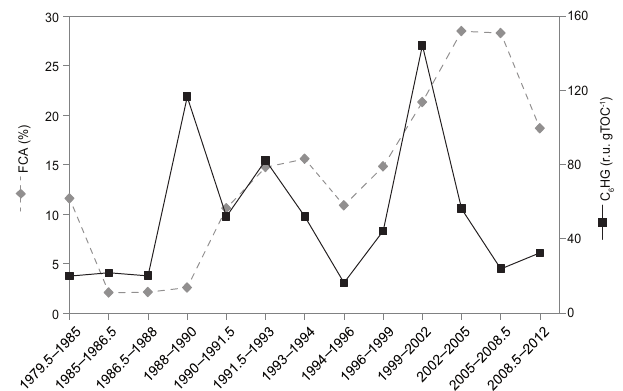
Figure 6. Abundance of heterocyst glycolipids (HGs) in the Baltic Sea over the period 1977–2012 (from MUC) compared with the fractional cyanobacteria accumulation (FCA, %) from the time pe- riod 1979–2012, as reported by Kahru et al.